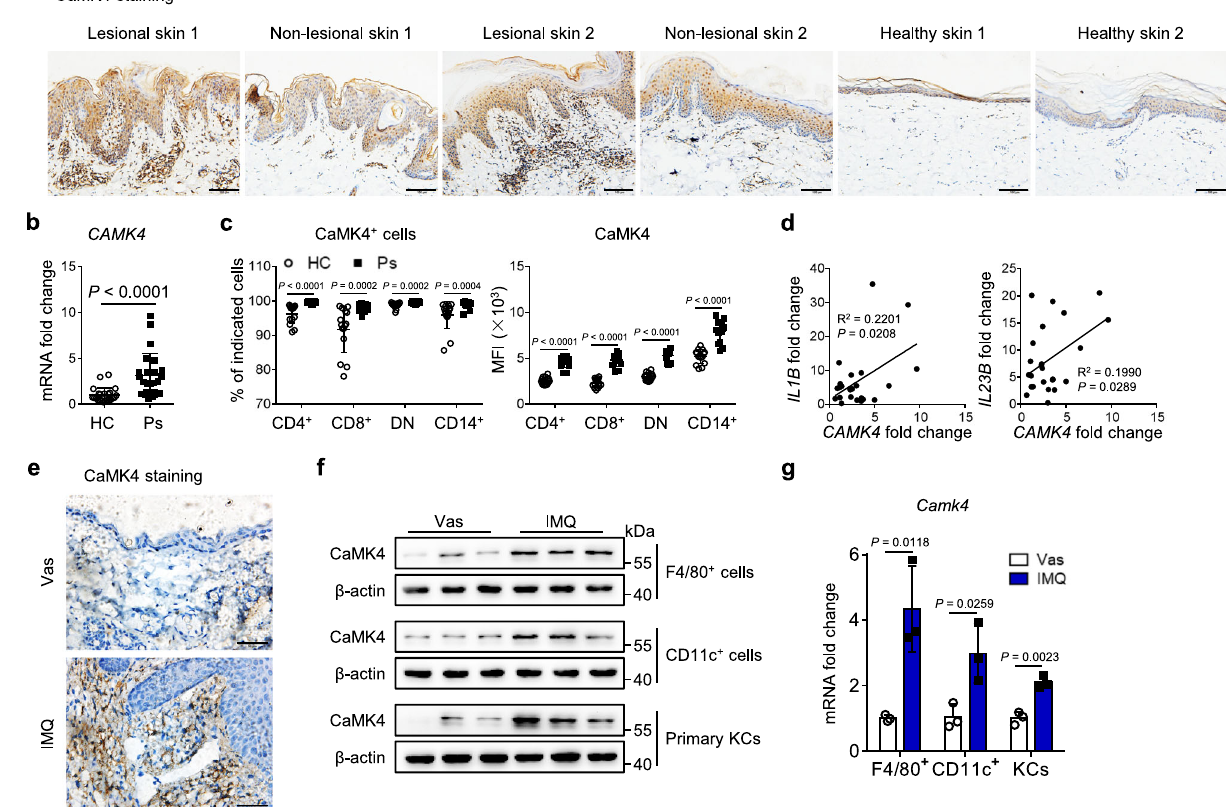
Fig. 1 | CaMK4 expression is increased in psoriatic lesional skin from patients with psoriasis and micewithIMQ-inducedpsoriasis. a Representative imagesof immunohistochemical staining for CaMK4 in human paired psoriatic lesional skin and non-lesional skin ( n =4) and healthy skin ( n =7). Scale bar=100 μ m. b The mRNA level of CAMK4 in the cells of peripheral blood from healthy controls (HCs, n =24)andpatientswithpsoriasis(Ps, n =24). c TheproportionofCaMK4 + cellsand the MFI of CaMK4 in peripheral T cell subsets and CD14 + monocytes from healthy controls ( n =15) and patients with psoriasis ( n =12). d The relationships between the expression ofpro-in fl ammatorycytokines and CAMK4 inthe cells ofperipheral blood from patients with psoriasis ( n =24). e Representative images of CaMK4-